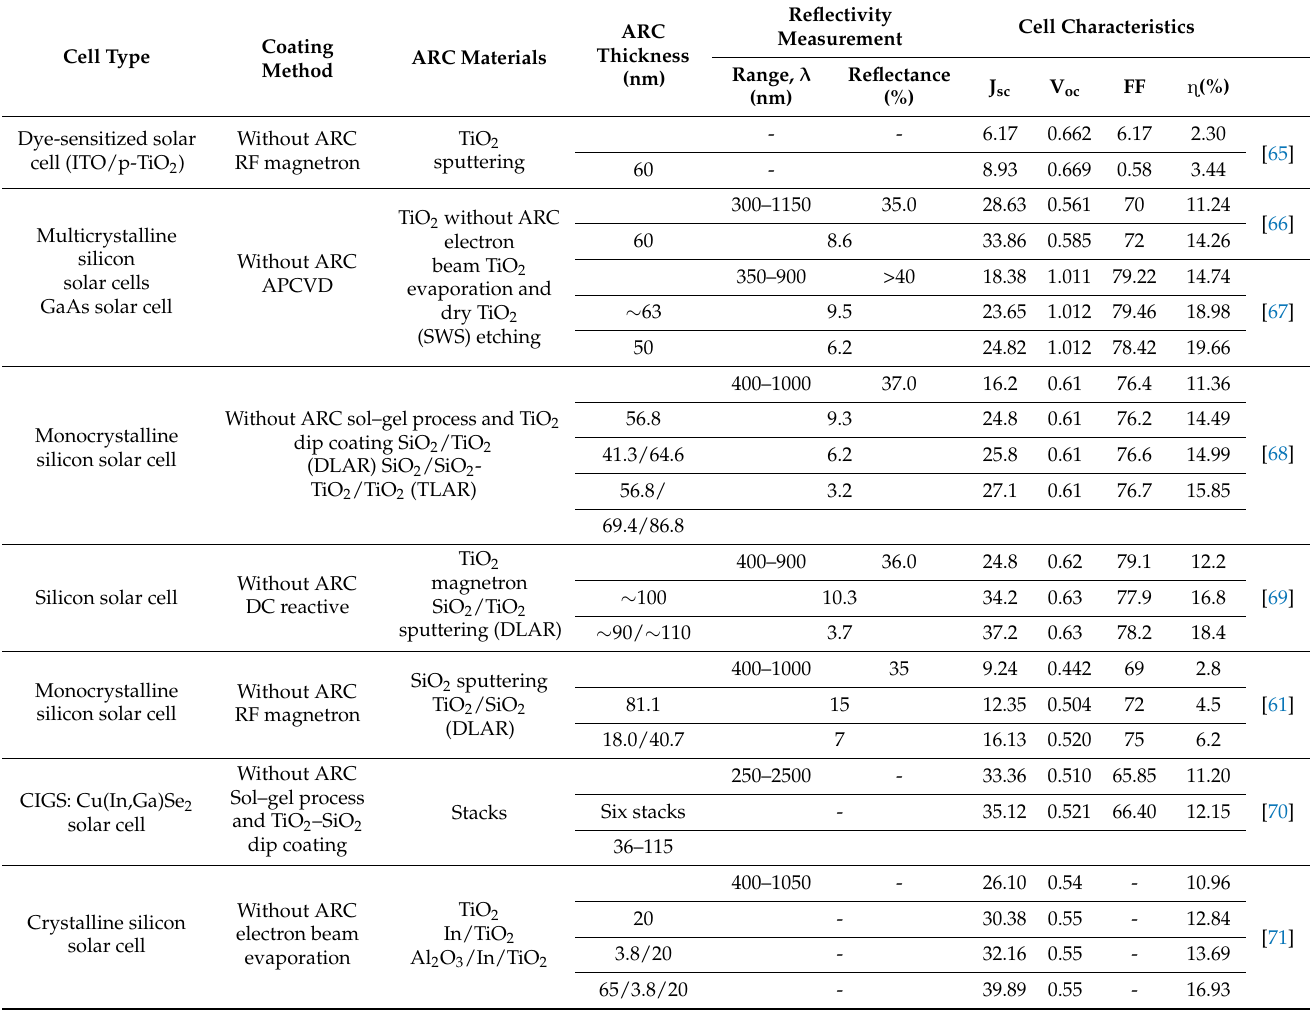
Table 2. Notable achievements in the development of TiO 2 -based anti-reflective coatings (ARCs) and figures of merit showing the resulting enhancement in solar cells’